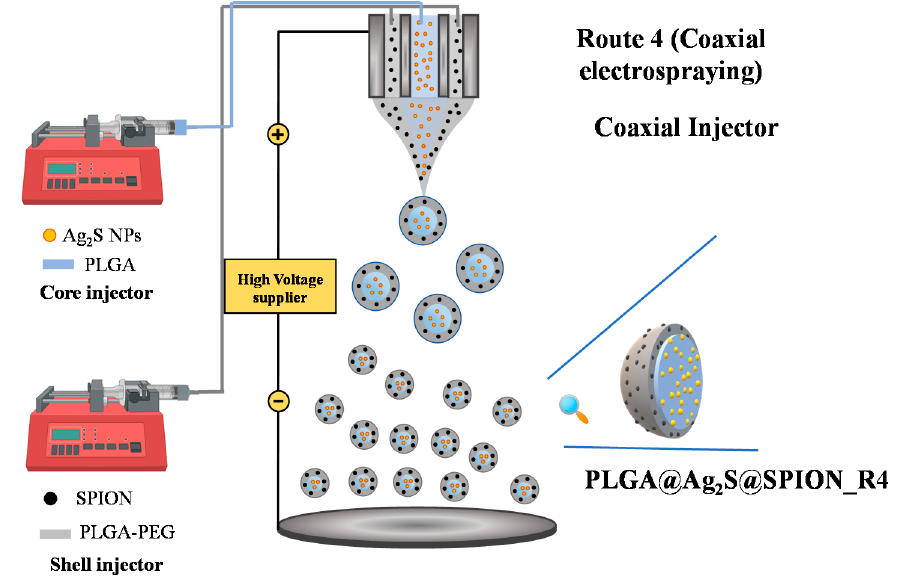
Table 1. Composition in percentage and place of injection of the different